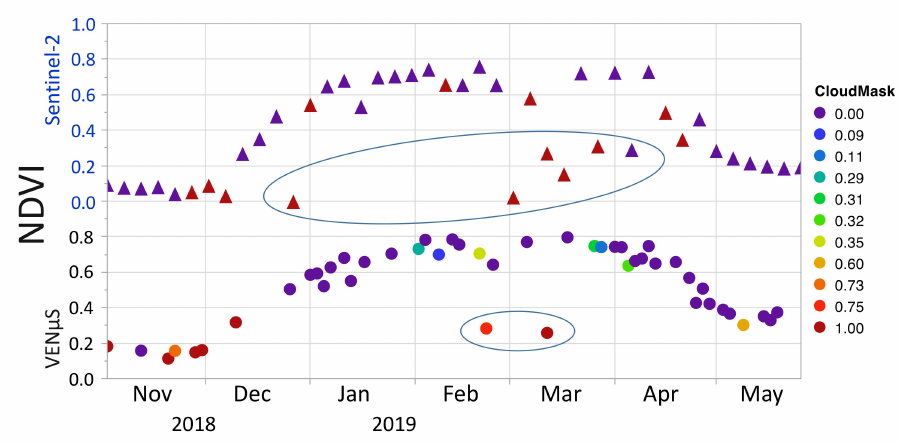
Figure 2. NDVI phenology of a field, as retrieved by VEN µ S and Sentinel-2. CloudMask data are for the whole tile.